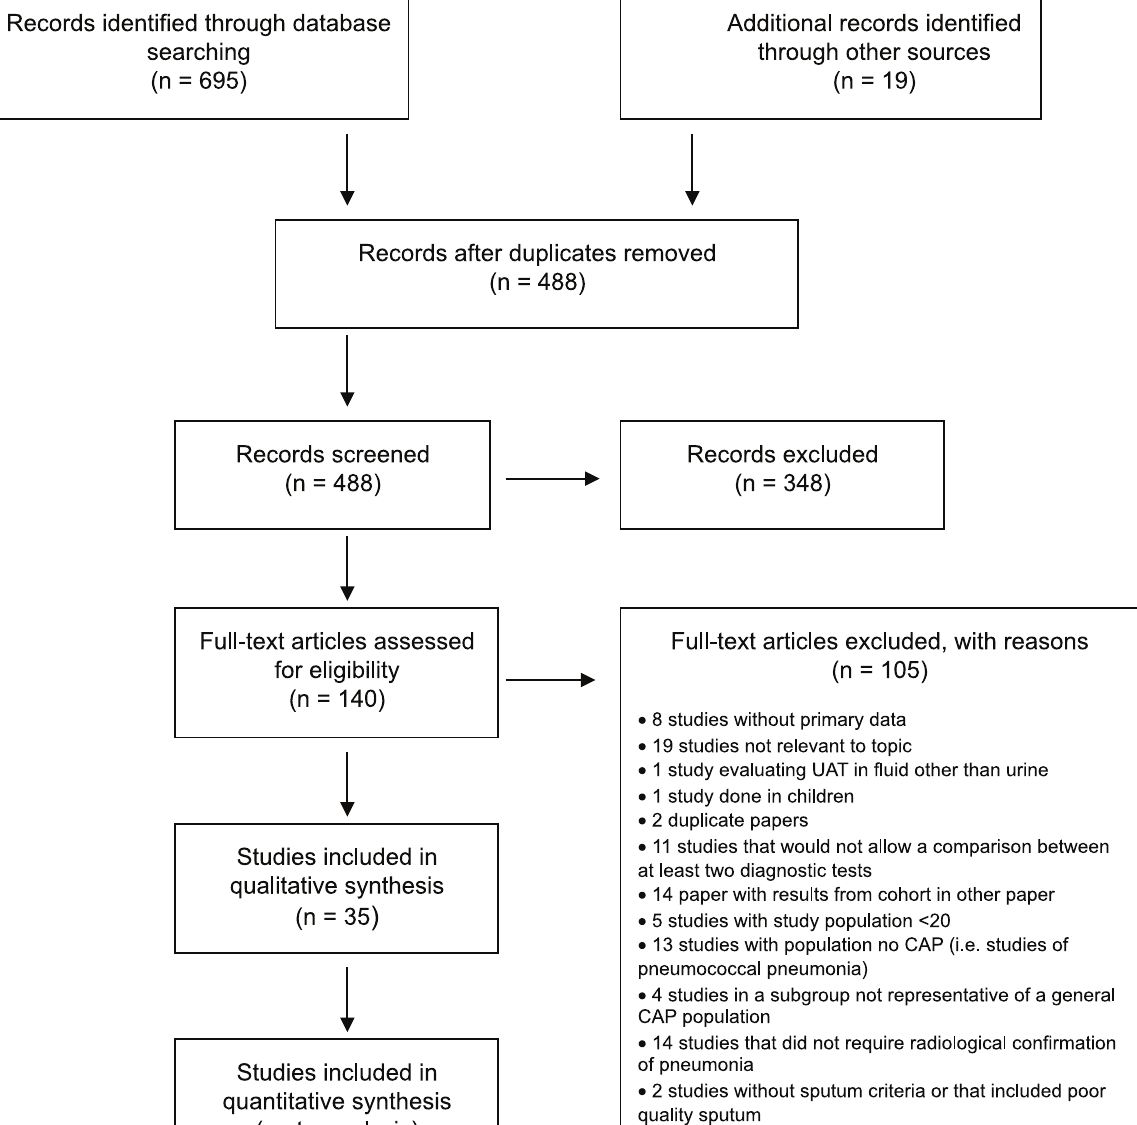
Figure 3. Flow diagram for the selection of studies.